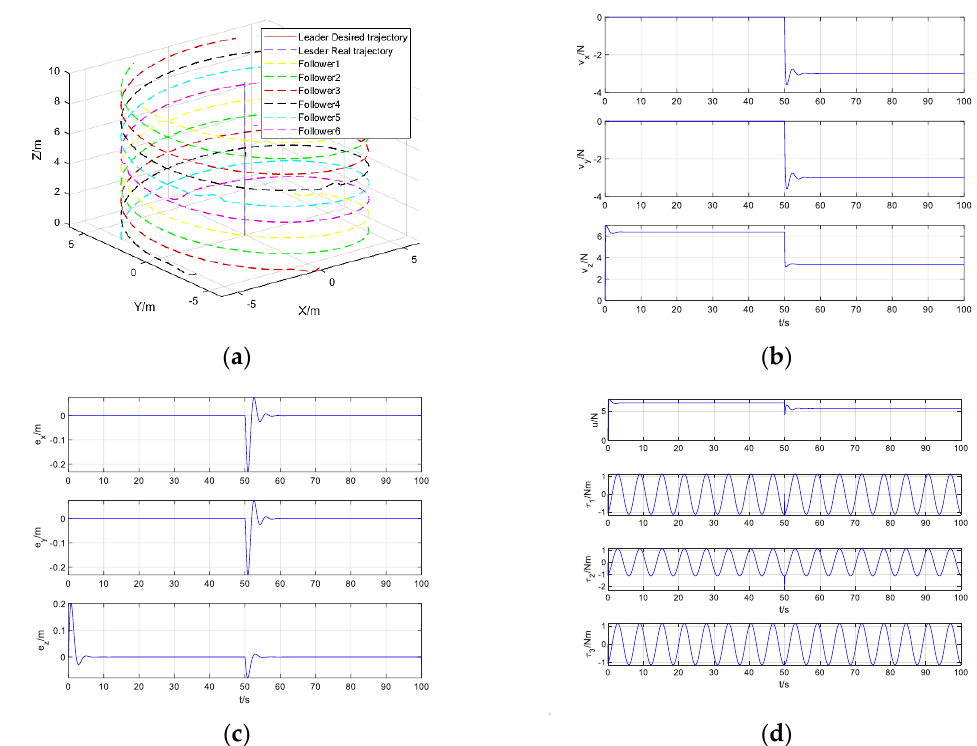
Figure 7. Simulation results of quadrotor formation cooperative trajectory tracking when increase the disturbance: ( a ) Formation cooperative trajectory tracking; ( b ) Virtual control input; ( c ) Trajectory tracking error; ( d ) Control input.